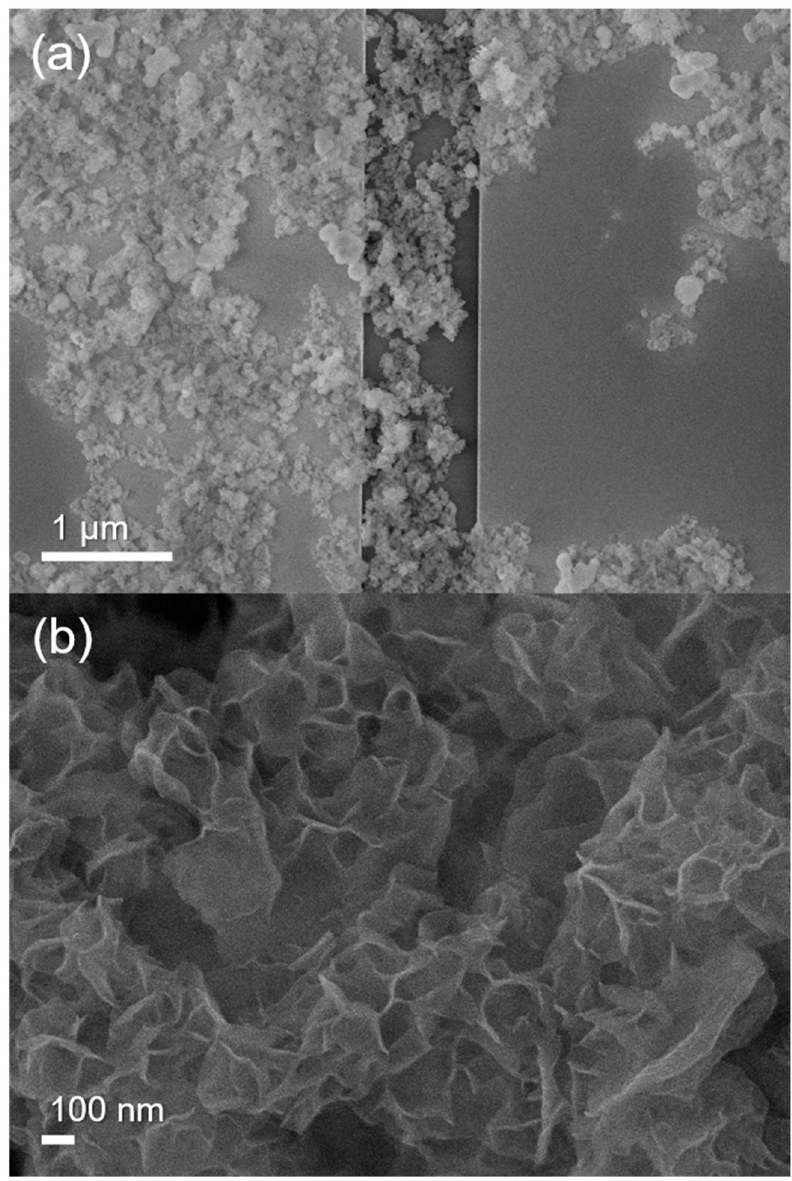
Figure 5. ( a ) High- and ( b ) low-resolution SEM images of the Co(OH) x F 2 − x nanosheets annealed at 350 °C for 2 h on device.